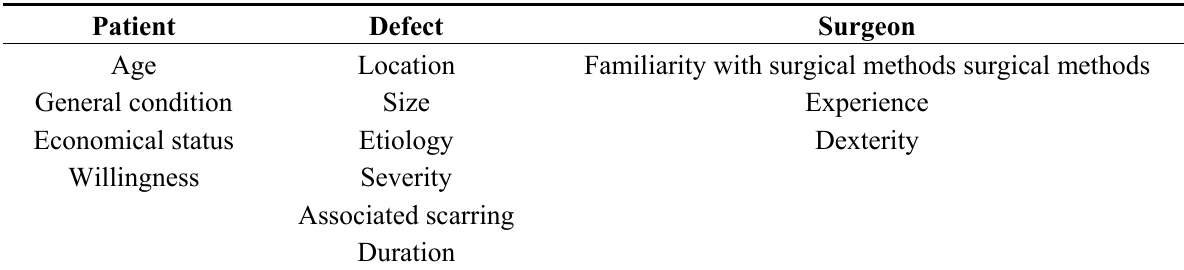
Table 2. Tabular form of flap selection